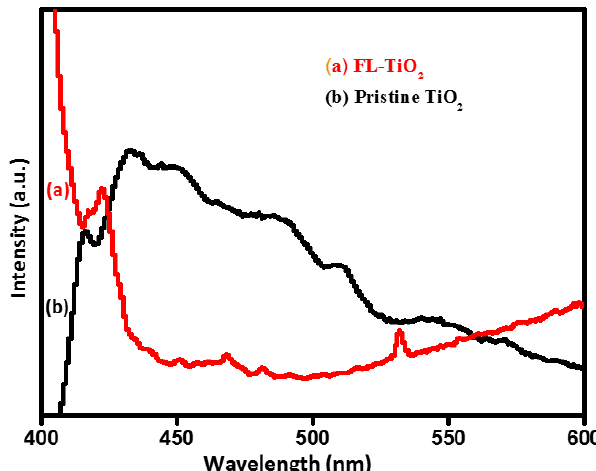
Figure 7. Photoluminescence spectra of TiO 2 material excited at 395 nm excitation wavelength ( a ) FL–TiO 2 and ( b ) Pristine TiO 2 .